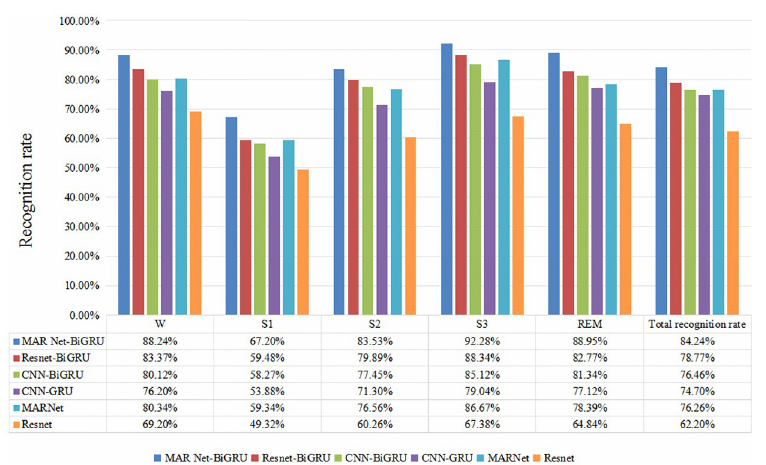
Fig 10. On the Sleep-EDF dataset, classification recall rates of each sleep period under different algorithms.